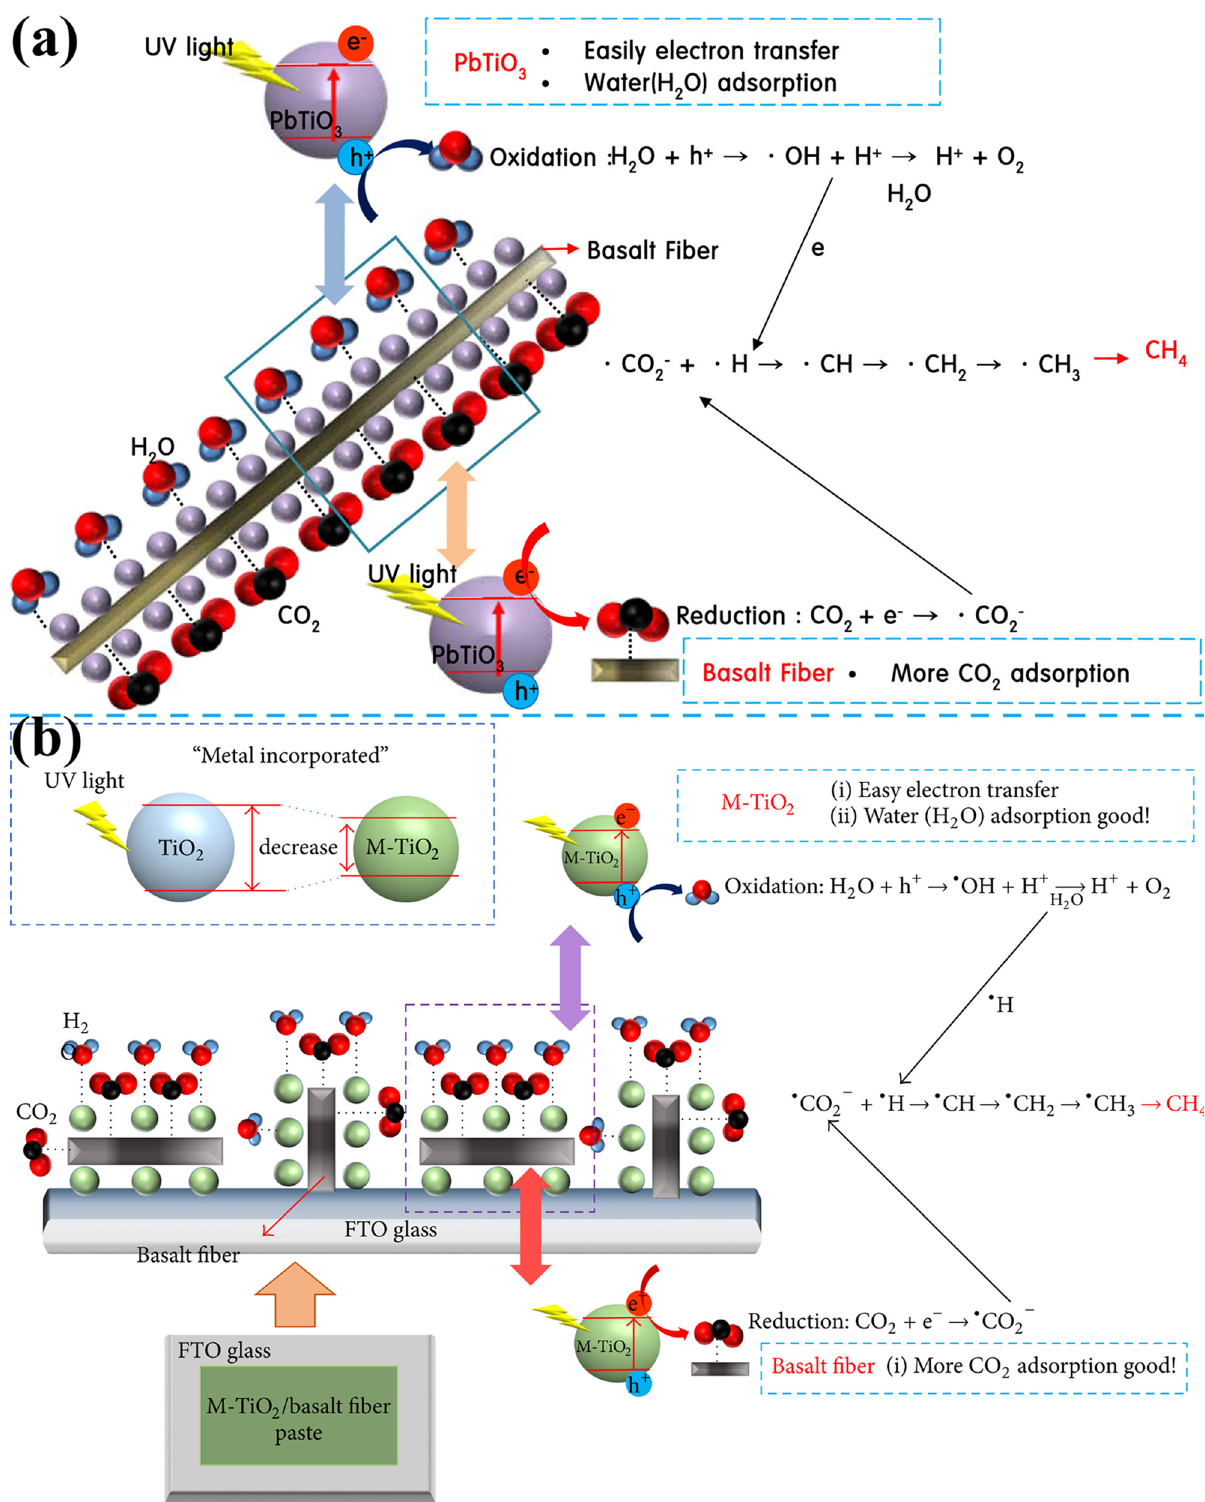
Figure 5: Mechanism of CH 4 production by photoreduction of CO 2 : ( a ) BF@PbTiO 3 core – shell composites [ 67 ] and ( b ) M - TiO 2 /basalt fi ber fi lms [ 68 ]